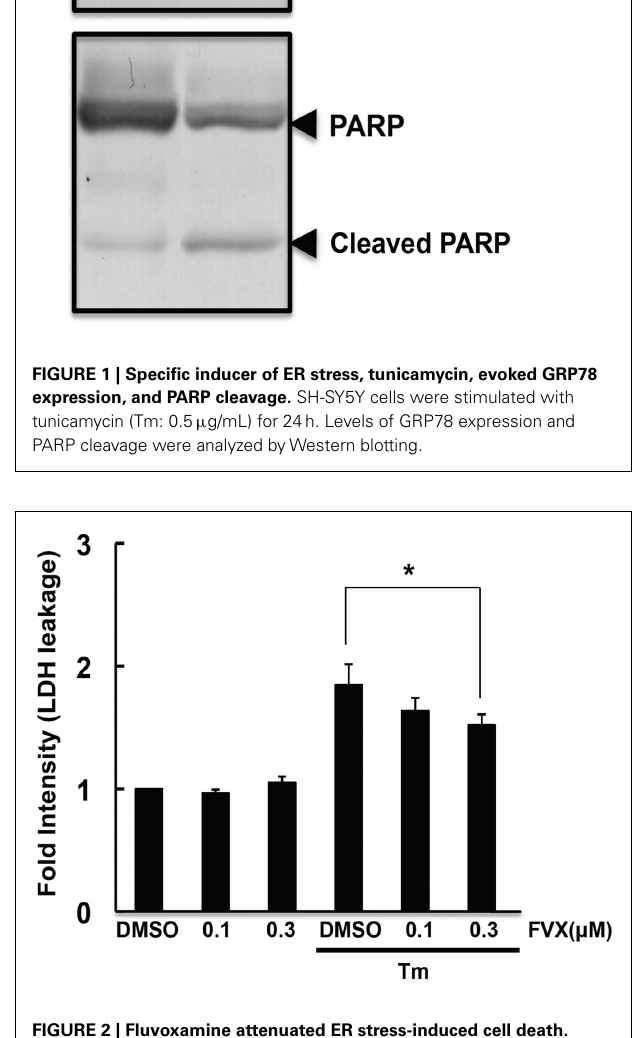
FIGURE 2 | Fluvoxamine attenuated ER stress-induced cell death. SH-SY5Y cells were pre-incubated with fluvoxamine (FVX: 0.1 μ M, 0.3 μ M) for 1h and then stimulated with tunicamycin (Tm: 0.5 μ g/mL) for 36h. LDH activity was measured as an indicator of cytotoxicity. * P <